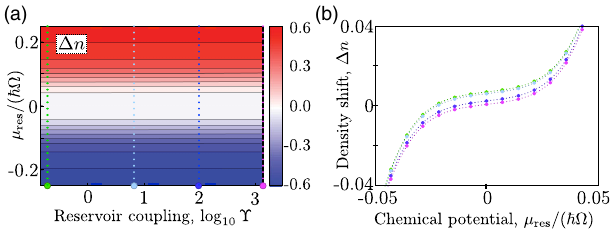
FIG. 7. The offset density Δ n . (a) Δ n as a function of the reservoir chemical potential μ and the coupling of the Fermi res reservoir log 10 ϒ . Incompressible behavior can be seen when μ ≈ 0 . (b) Vertical cuts of (a), showing Δ n as a function of μ res res for several coupling strengths to the Fermi reservoir, with values indicated by the dashed lines in (a). The small slope can be attributed to activated behavior due to the finite temperature of the